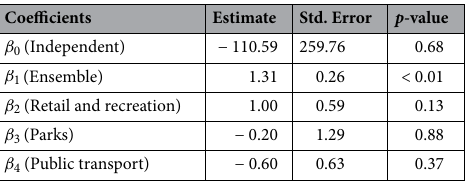
Table 9. Multivariate regression for DS2 training period. R 2 = 0, 79 , p -value < 0.01 .